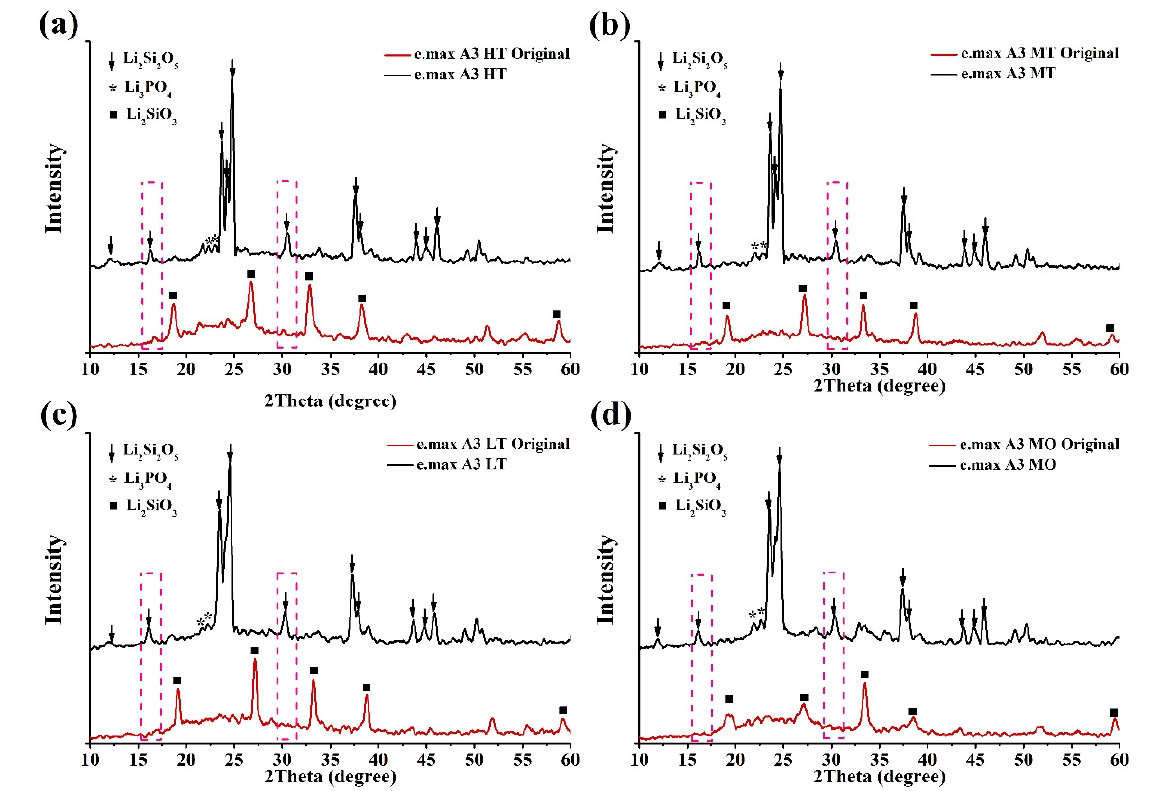
Figure 9. XRD representative patterns of the e.max CAD ceramics (A3). ( a ) High translucency, ( b ) medium translucency, ( c ) low translucency, and ( d ) medium opacity.